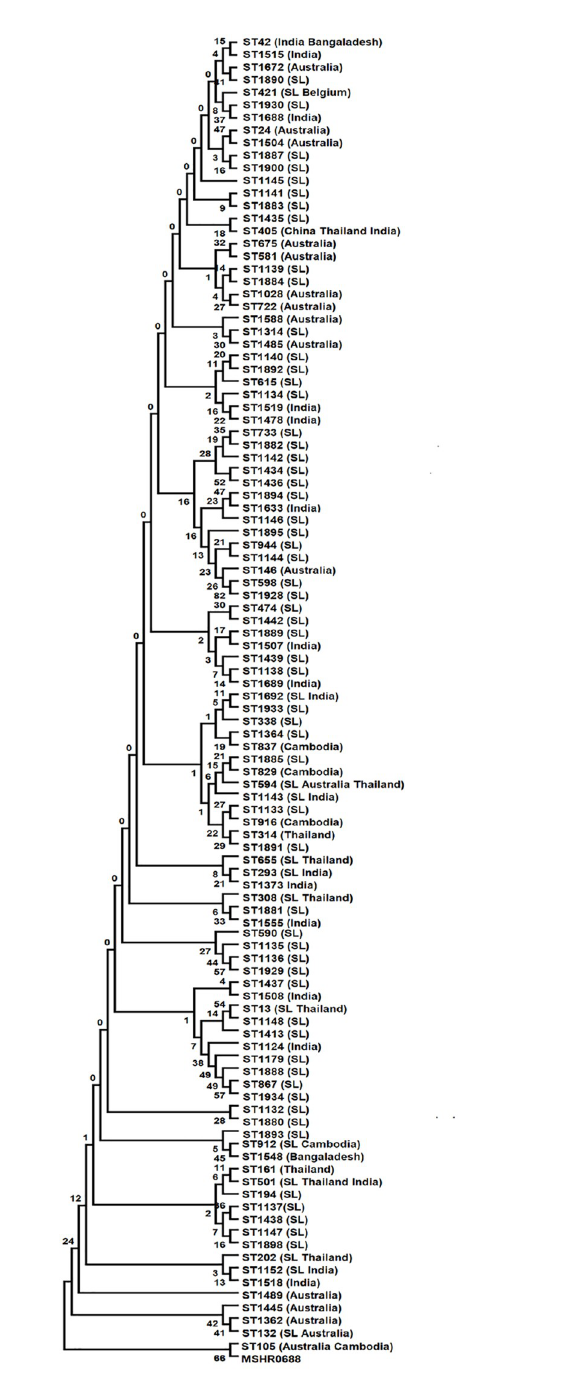
Fig 6. Minimum spanning tree showing the evolutionary relationship of 107 known STs including all 71 STs reported from Sri Lanka inferred using the Maximum likelihood method. Tree constructed from the concatenated sequences of the seven MLST loci. The optimal tree with the sum of branch length = 0.0378947.